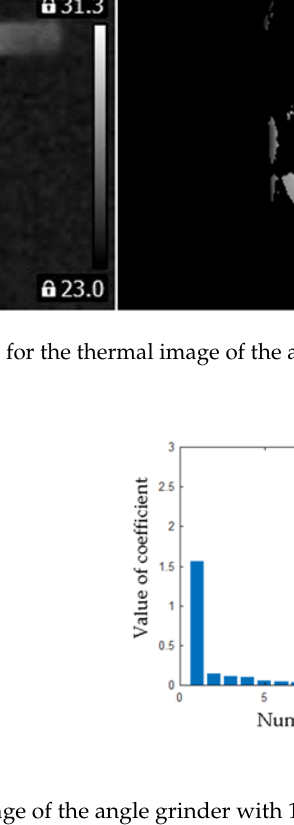
Figure 19. ( a ) Histogram of the matrix V for the thermal image of the angle grinder with 1 blocked air inlet ( b ) Values of PCA of the matrix V for the thermal image of the angle grinder with 1 blocked air inlet. Computed matrix V for the angle grinder with 2 blocked air inlets was presented in Figure 20. Histograms and PCA values for the angle grinder with 2 blocked air inlets were presented in Figure 21.